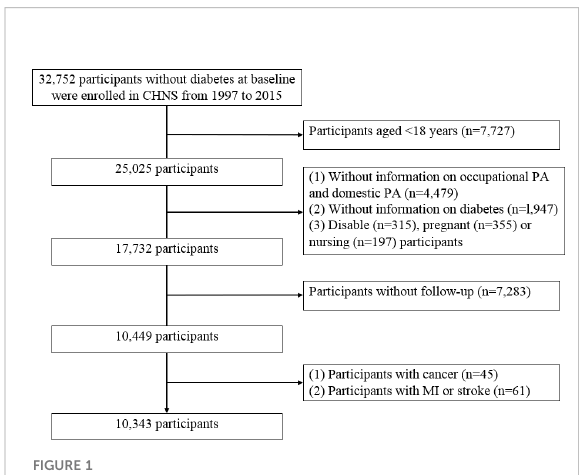
FIGURE 1 Study population fl owchart. Notion: CHNS, China Health and Nutrition Survey; PA, physical activity; MI, myocardial